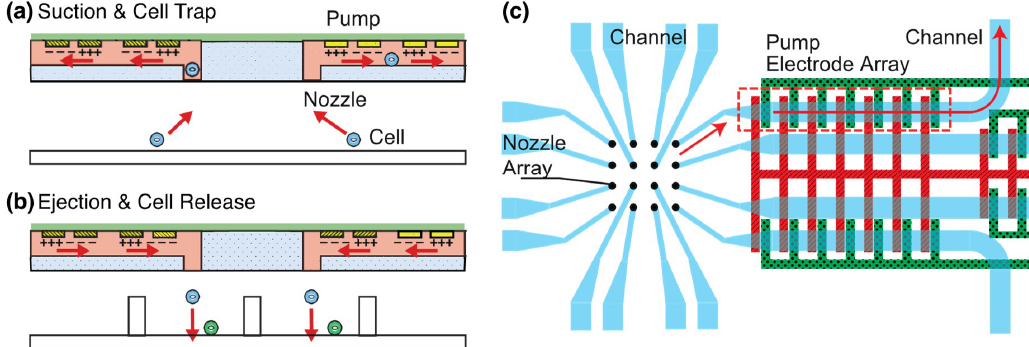
Figure 1. The schematic of a nozzle array integrated with electrokinetic pumps for cell manipulation. ( a ) Suction and trap of single cells in an array format with nozzles. ( b ) Ejection and release of the cells from the nozzles. ( c ) Schematic view of 4 × 4 nozzles integrated with pumps. One of the electrodes (green) is connected to a signal voltage (DC-biased AC voltage) and the other electrode (red) is connected to the ground.